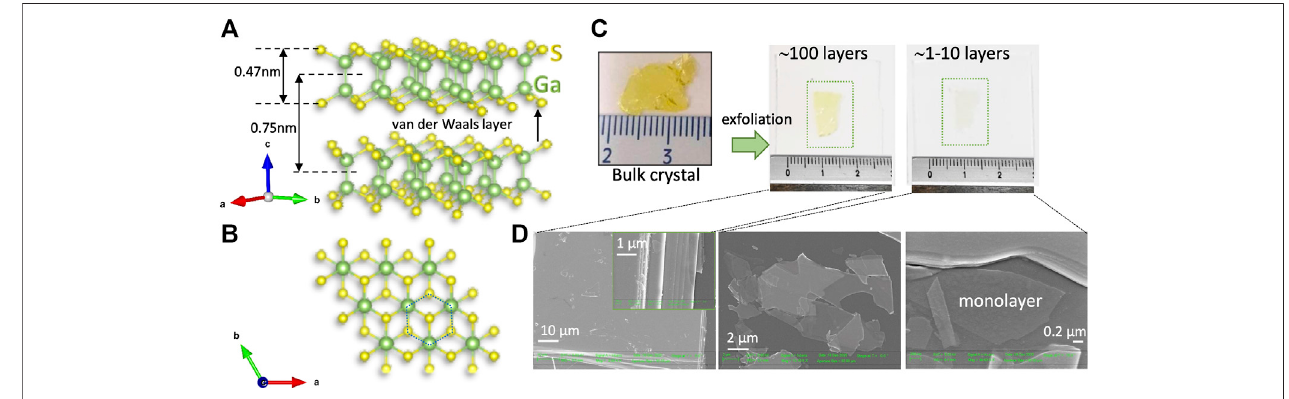
FIGURE 1 | (A) Side and (B) top view of the crystalline structure of 2H-GaS. (C) Images of the yellow bulk GaS crystal and of the mechanical exfoliated layers on glass substrate, showingthereductionoftheyellowcolorbyreducingthenumberoflayers. (D) SEMimagesoftheexfoliatedGaSshowingitslayeredstructuredownto monolayer. The inset in (D) is for the multilayer border where the piling up of the various layers can be clearly seen and layers can be